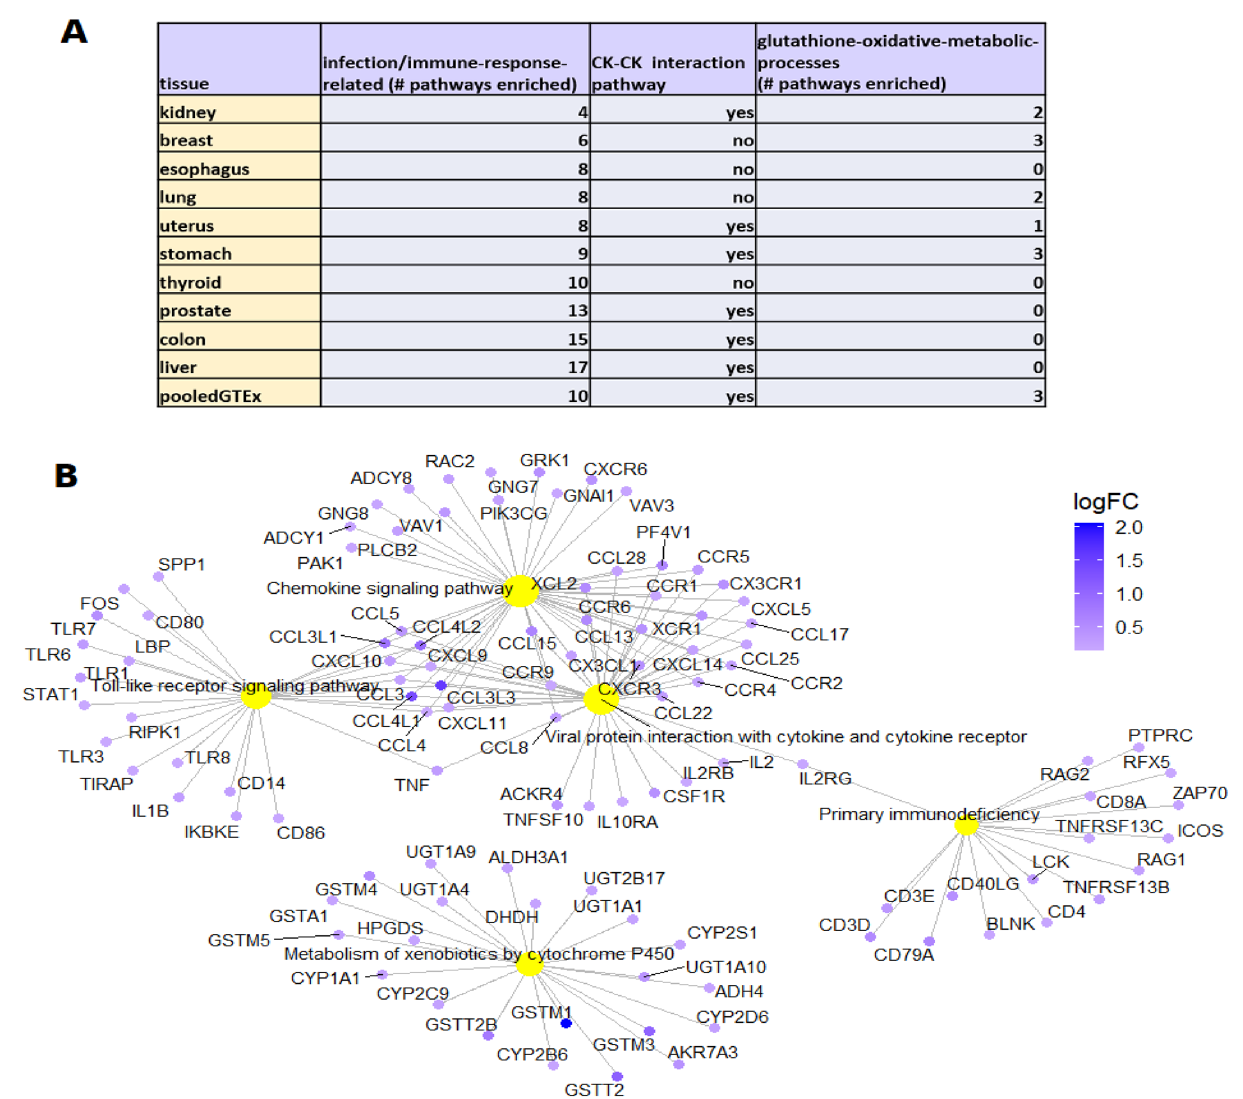
Figure 1. Gene Set Enrichment Analysis (GSEA) enrichment of KEGG pathways in African Americans compared to European Americans in pooled GTEx data. GSEA comprehensively analyses data for expression of all genes, rather than only the DE genes. ( A ) The most common pathways enriched among upregulated genes in African Americans for tissue-types in GTEx. See Additional File 3 for complete list of enriched pathways in 25 tissue-types. CK-CK, cytokine-cytokine receptor interaction; glutathione-oxidative metabolism includes (oxidative) metabolism of xenobiotics. The full enrichment analysis for each tissue-type is shown in Supplementary Table S57–S59. ( B ) The five most highly enriched pathways among upregulated genes of pooled samples from all tissue-types in GTEx are: Tol-like receptor signaling; chemokine signaling; primary immunodeficiency; viral protein interaction with cytokine and cytokine receptor; metabolism of xenobiotics by cytochrome motility 30 is the F8A/HAP40 (HAP40) protein, encoded by three genes (F8A1, F8A2, and F8A3) in humans 31 . The three F8A proteins are identical in sequence, and thus likely have the same molecular function. F8A1 is more highly expressed by about twofold in European Americans in almost every tissue-type analyzed (Fig. 3). Conversely, F8A2 and F8A3 are more highly expressed in African Americans. Expression of F8A2 in African Americans is up to 40-fold greater; expression of F8A3 is up to 6.6-fold greater. In LUSC, F8A2 and F8A3 are the only genes DE > 2 -fold (Supplementary Table S7). F8A2 and F8A3 follow a similar trend, being the difference in levels of F8A2 and F8A3 expression between the two populations is due to their extremely low/ undetectable levels of expression in a large proportion of the European American population. Because of the vast differences in expression levels of the three HAP40-encoding genes between African Americans and European Americans, the paucity of literature on HAP40 32 , and the unclear relationships among